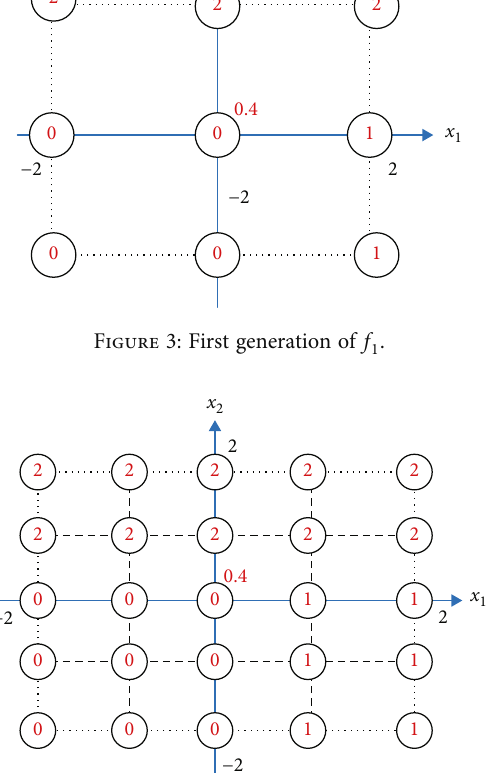
Figure 4: Second generation of f